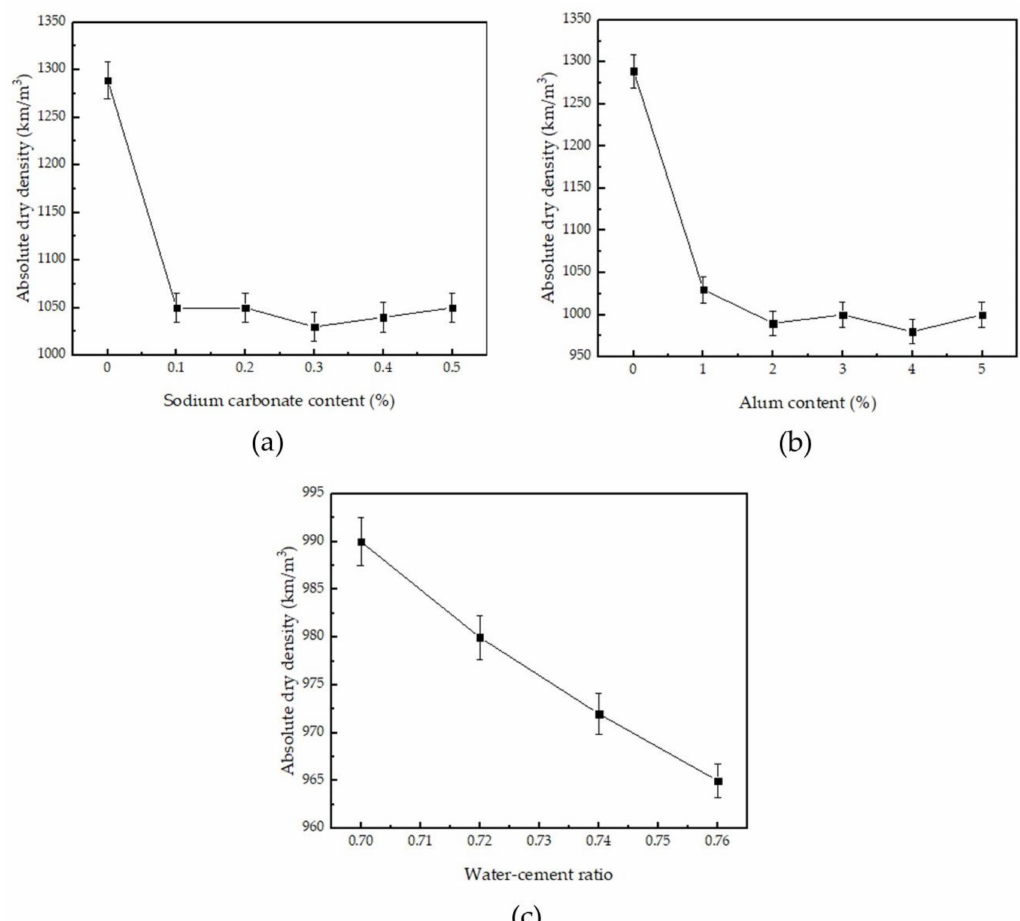
Figure 4. Effect of sodium carbonate and alum on the absolute dry density of phosphogypsum: ( a ) alum content is 1%, and sodium carbonate content changed; ( b ) sodium carbonate content is 0.3%, and alum content changed; and ( c ) sodium carbonate content is 0.3%, alum content is 2%, and water–cement ratio